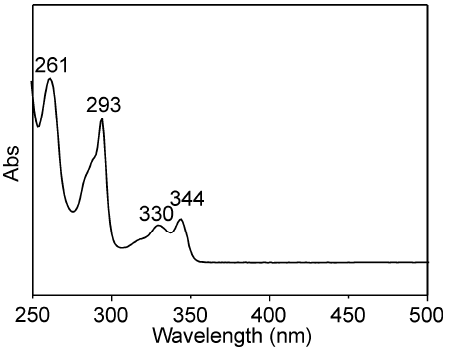
Figure 7. Absorption spectrum of PPO- b -PEPK solution (THF, 1 mg/mL).